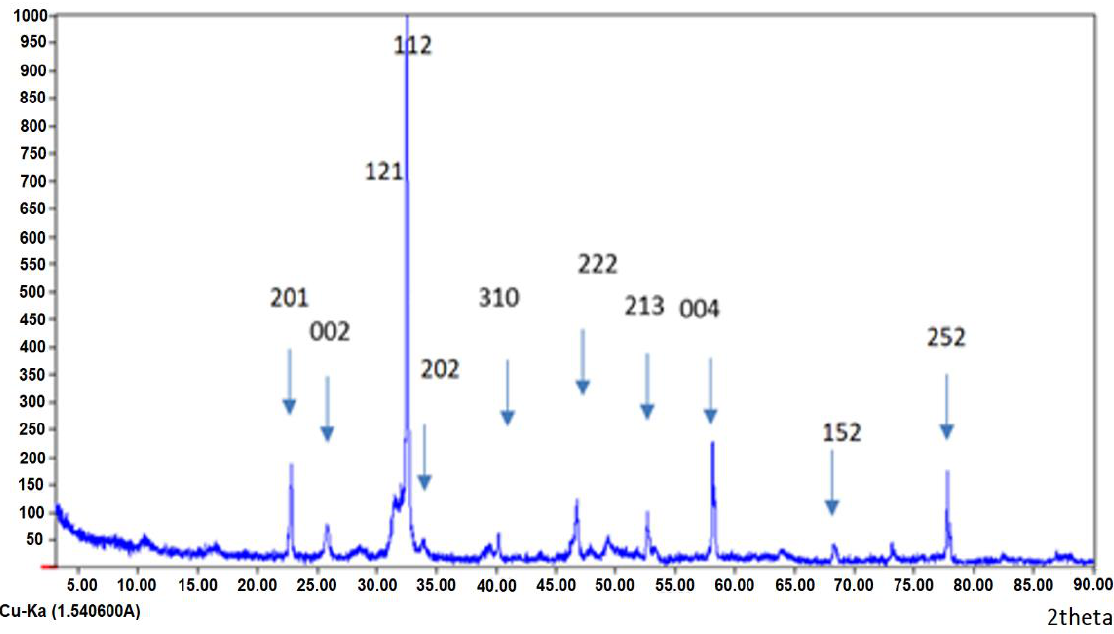
Figure 6. XRD diffractogram of the HAp/HPMC 30/70 composite. The width at mid-height of the index lines (002) and (310) was used to determine the average crystallite size using Scherrer’s formula [60–65]. The dimensions of the crystallites in the directions perpendicular to the (002) or (310) planes are given in Table 1.